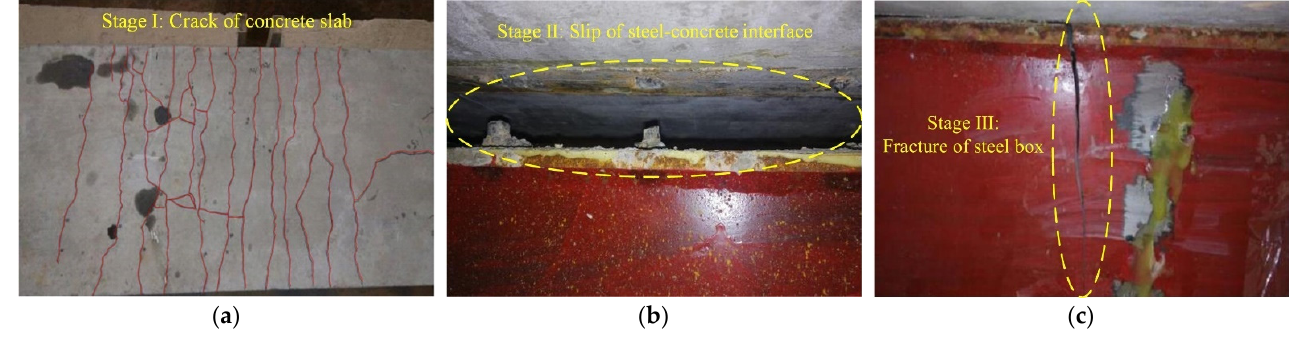
Figure 6. Schematic diagram of each stage under fatigue tests: ( a ) stage I; ( b ) stage II; ( c ) stage III.